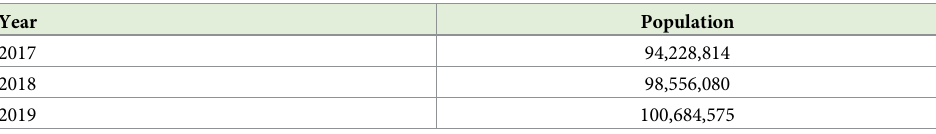
Table 1. Ethiopian population projection [13,